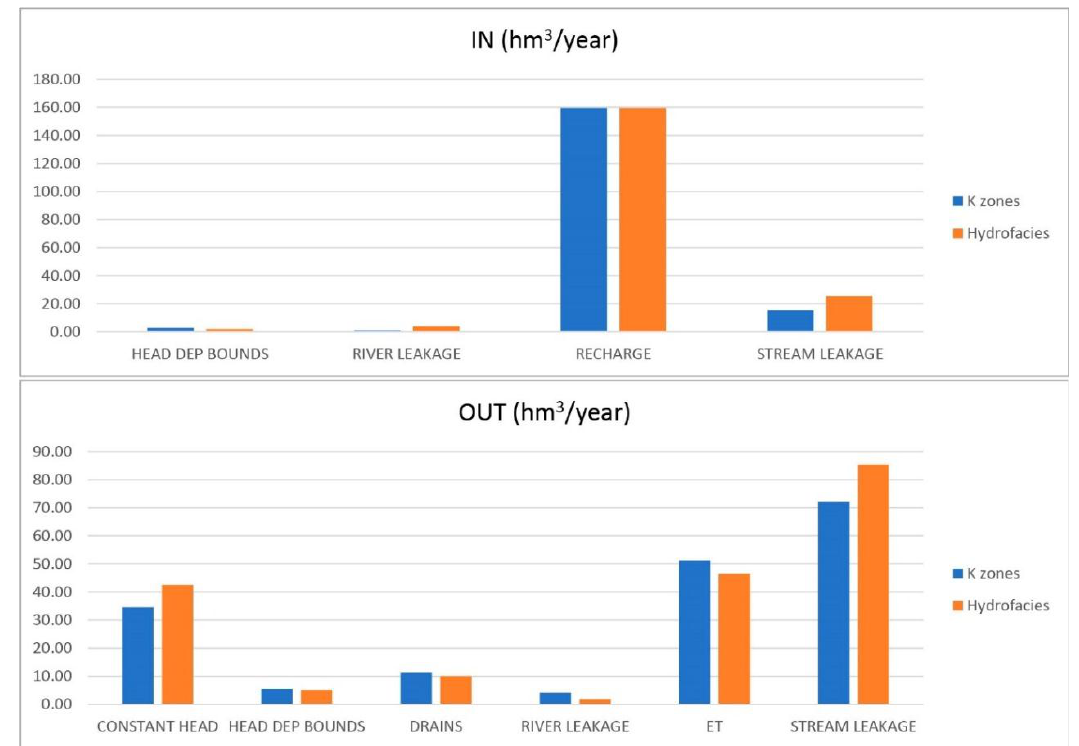
Figure 8. In and out water budget (hm 3 /year) comparison between the zoned model and the model with integrated 3D simulation.